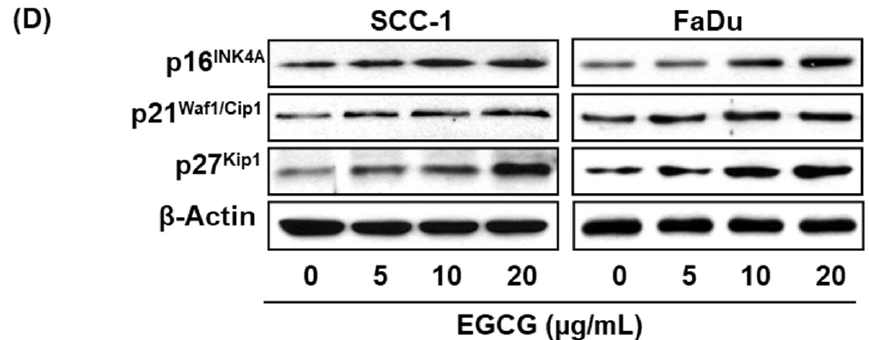
Figure 5. Effects of EGCG on DNA demethylation in HNSCC cells. SCC-1 and FaDu cells were